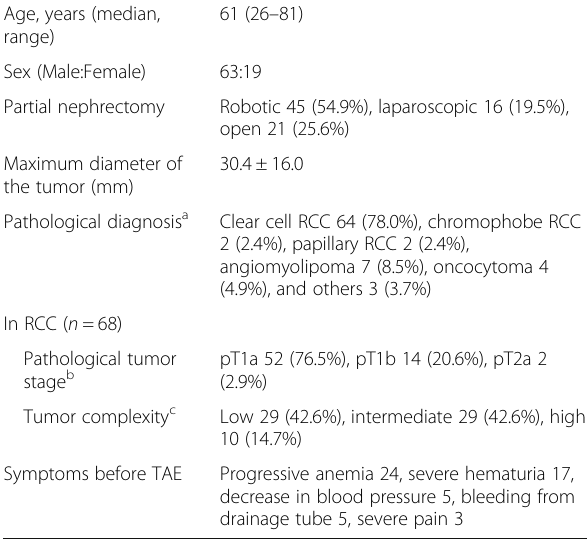
Table 1 Patient characteristics